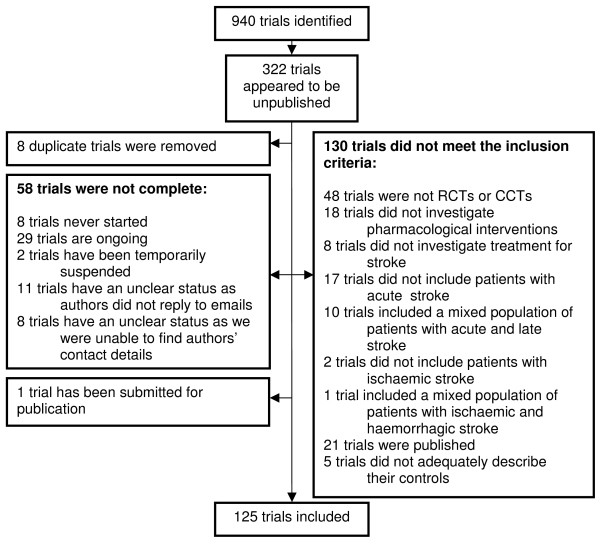
Trials flowchart.